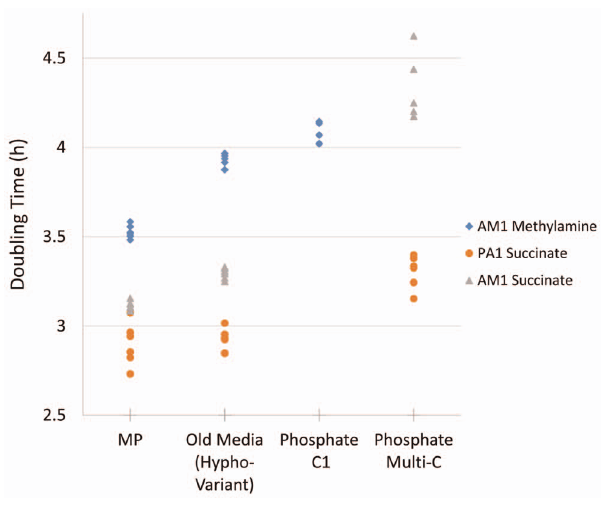
Figure 3. Growth rates of AM1 D cel and PA1 D cel on different media formulations and carbon sources. Measurements were taken every 50 minutes. The data for the Choi medium is not shown because the high concentrations of metals altered the OD readings (Fig. S3) such that meaningful growth rate comparisons could not be made.